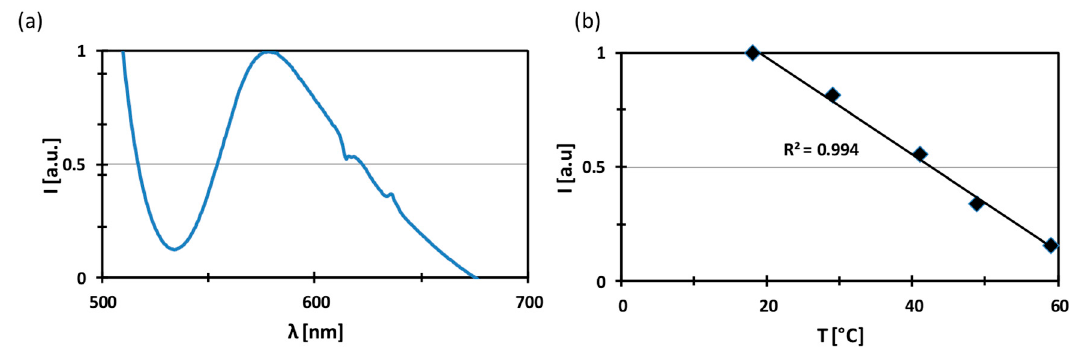
Figure 4. ( a )Emission of PVDF ENM excited at 450 nm at 18 °C; ( b ) Effect of the temperature on the intensity of the emission at 572 nm.